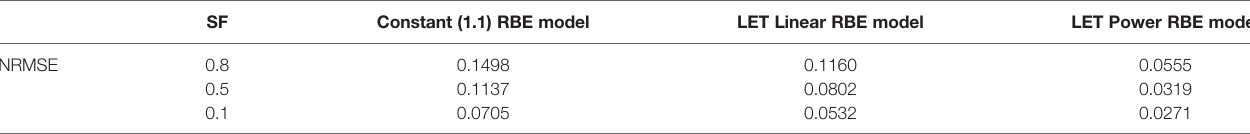
SF Constant (1.1) RBE model